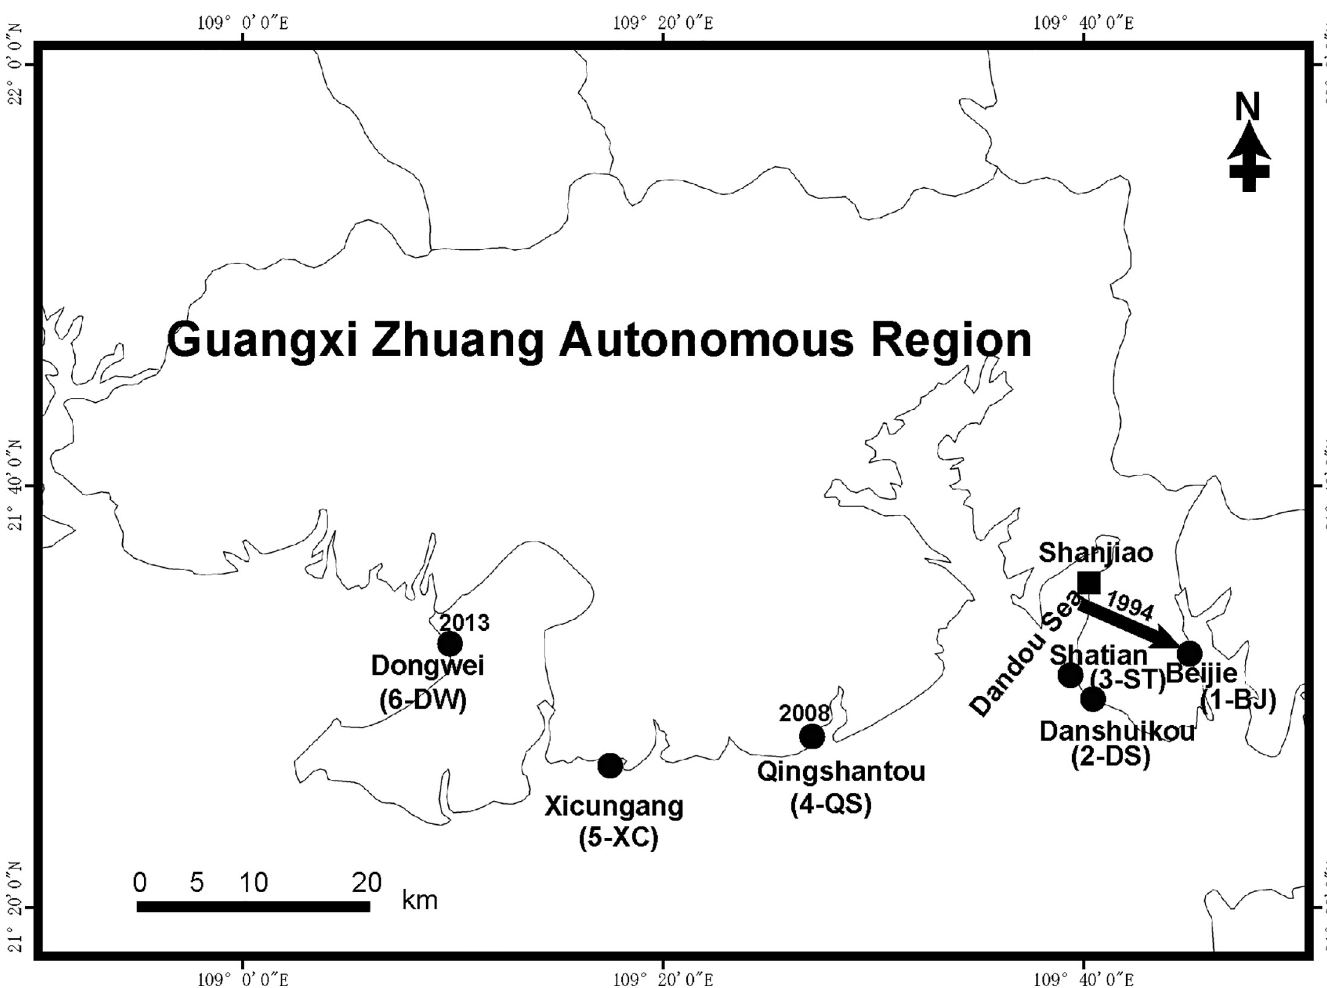
Fig 1. Introduction history and population location of Spartina alterniflora in Guangxi, China. This species was first introduced into Shanjiao Village (which belongs to the Dandou Sea coast) of Guangxi (GX) from Fujian (FJ) in 1980 and into Beijie (1-BJ) in 1994 from the Dandou Sea coast. The population in Qingshantou (4-QS) was first detected in 2008, and that in Dongwei (6-DW) was first detected in